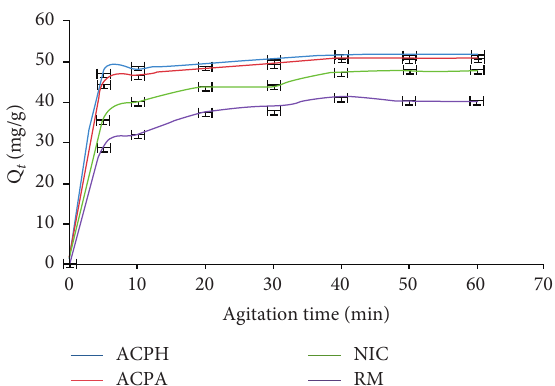
Figure 7: Effect of contact time on nickel(II) adsorption for ACPH, ACPA, NIC, and RM (volume � 20mL, Co � 200mg/L, pH � 4, adsorbent dose � 0.1 g, stirring rate 150rpm).